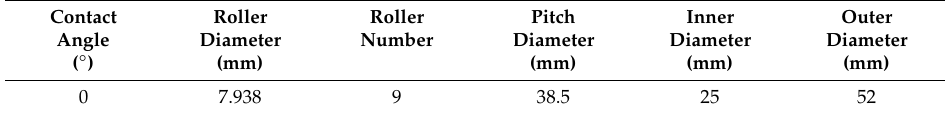
Table 1. Specifications of testing